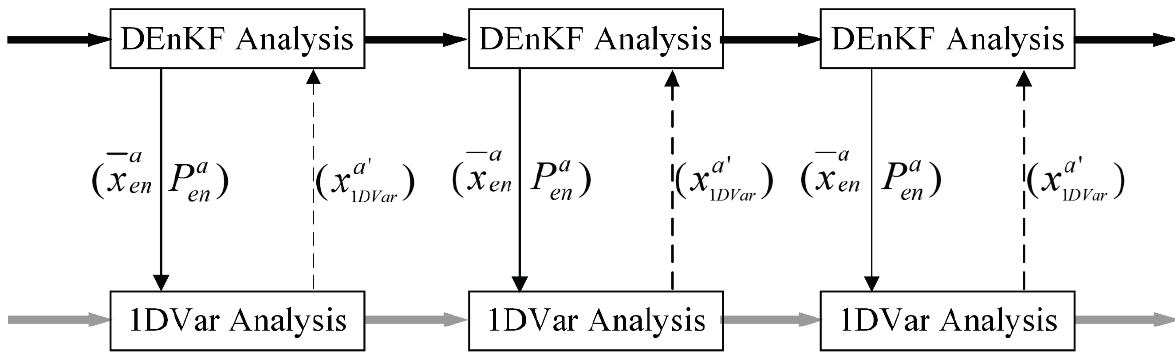
Figure 1. A hybrid analysis method of DEnVar which couples the DEnKF and the